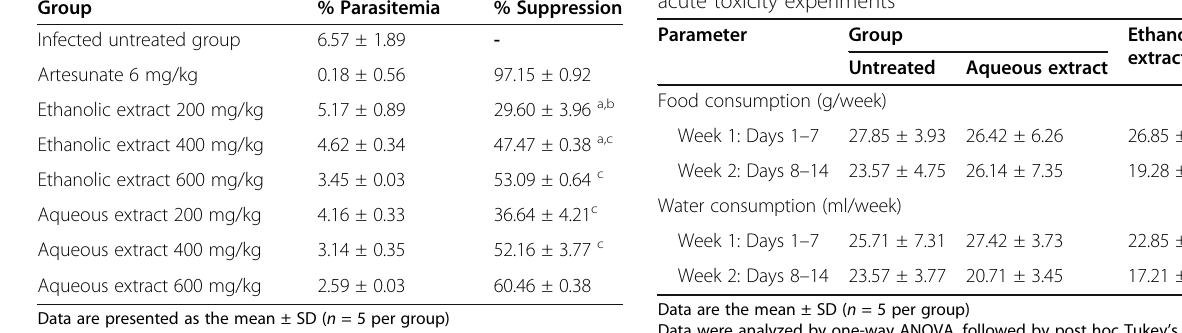
Table 4 Antimalarial activity of artesunate (a positive control), aqueous and ethanolic extracts